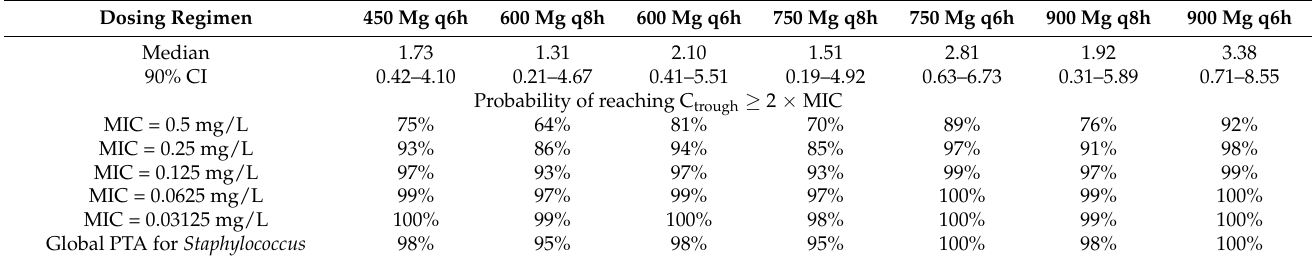
Table 3. Simulated clindamycin trough concentrations (median and 90% non-parametric confidence interval, CI) and probability of achieving the PK/PD targets of trough concentration (Ctrough) ≥ 2 and 8 × MIC per dosing